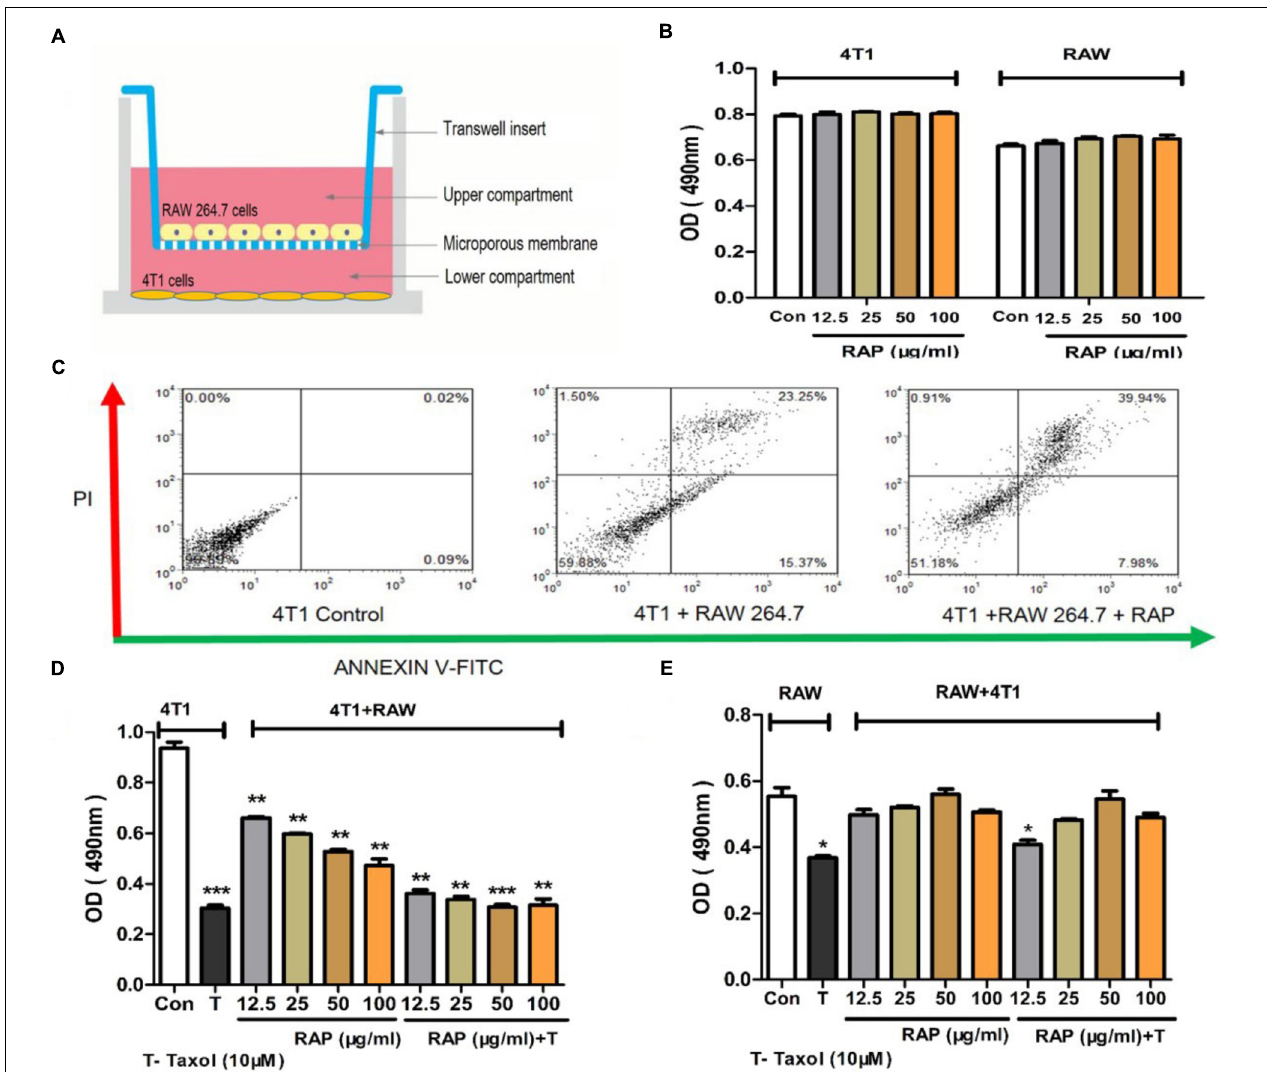
FIGURE 2 | Effects of RAP with/without Taxol on 4T1 and RAW 264.7 cells. (A) 4T1 and RAW 264.7 cells co-culture model; (B) 4T1 and RAW 264.7 cells were not stimulated by RAP directly; (C) Apoptosis of 4T1 cells in co-culture system induced by RAP (50 µ g/mL); (D) Proliferation of 4T1 and (E) RAW 264.7 cells in co-culture model treated by RAP with/ without Taxol. Data are presented as mean ± SD. Compared with the control group. ∗ p < 0.05, ∗∗ p < 0.01, ∗∗∗ p <